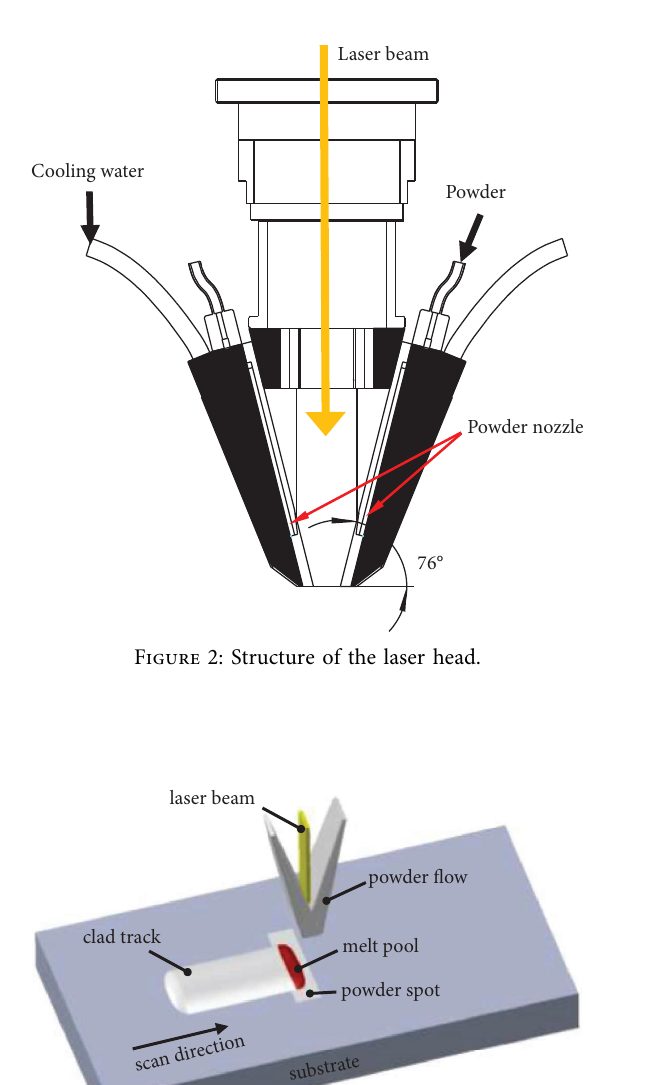
Figure 1: Schematic diagram of the laser cladding system.